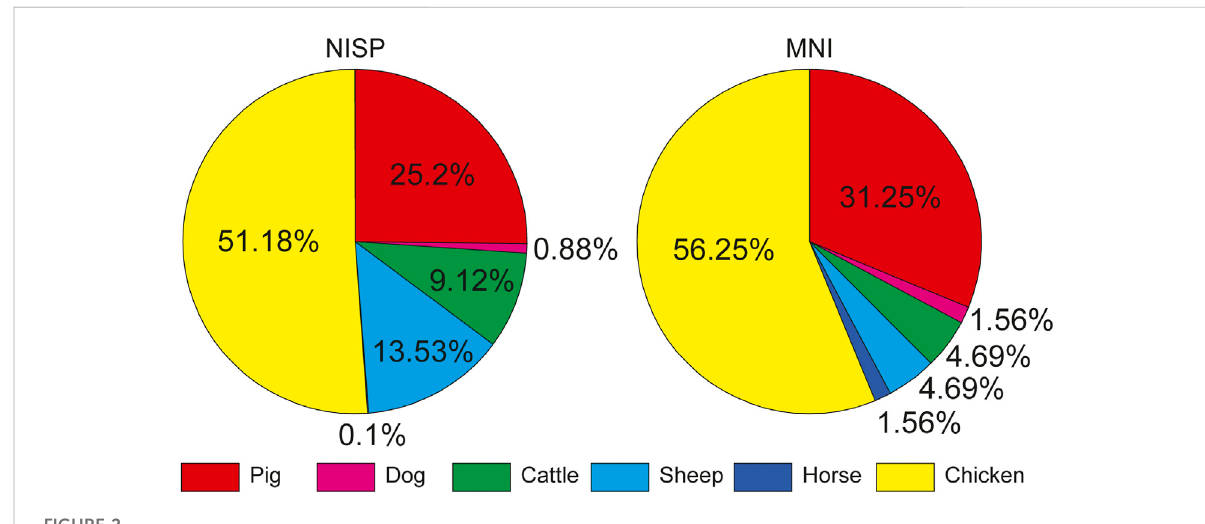
animal remains, with 147 fragments representing 8 individuals. The number of pig bones is similar to chicken bones, with 132 by NISP vs. 9 by MNI. The number of cattle bones is less than chickens and pigs during this phase, making up approximately one- fi fth of the total animal remains by NISP and one-tenth of the total animal remains by MNI. The remaining samples contained the bones of sheep and dogs, which make up a small proportion of the total